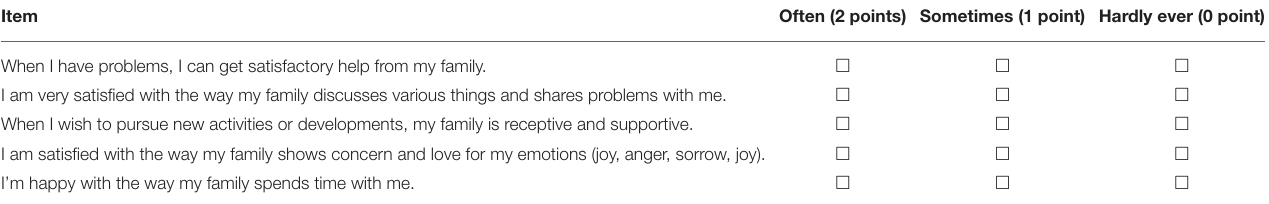
TABLE 2 | Family care index questionnaire